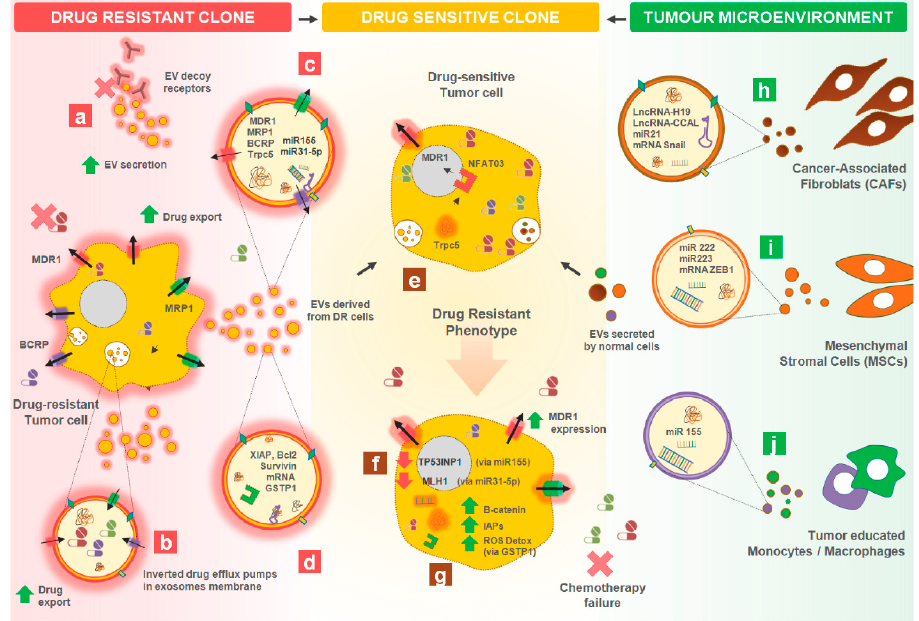
Figure 3. Impact of tumor-derived EVs in Cancer Therapy Resistance. EVs secreted from the few drug resistant (DR) cancer cells (on the left) or by normal cells within the tumor microenvironment (on the right) can contribute to exacerbate resistance in otherwise drug sensitive cancer cells (centre). ( a ) Exacerbated production of EVs by drug resistant cancer cell clones carrying on their surface the same tumour markers. These EVs will be targeted by certain monoclonal antibody-based therapeutics (e.g., trastuzumab, rituximab, etc.) and act as decoy receptors, lowering the availability of